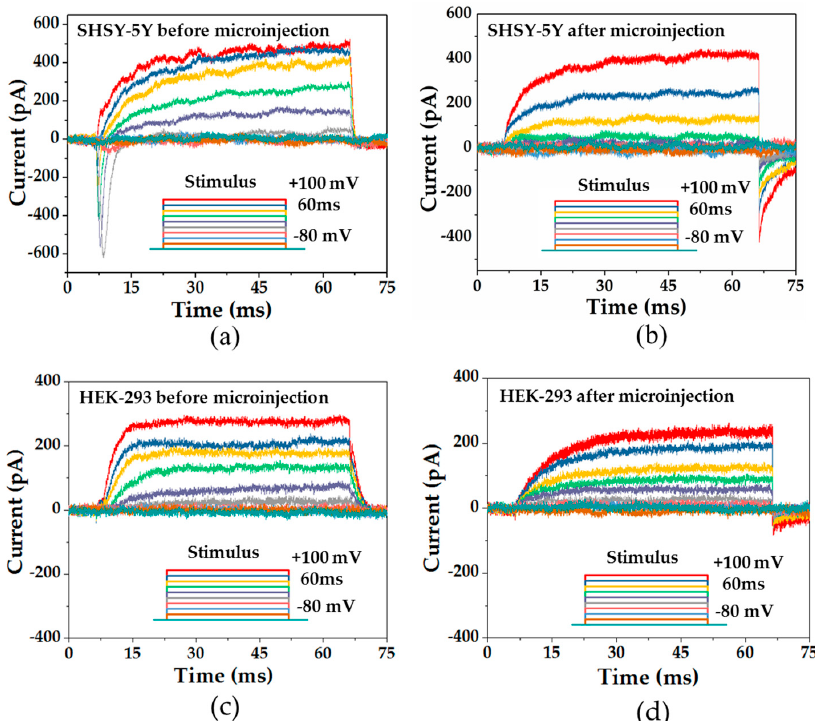
Figure 7. The current traces of ion channels and the voltage stimulus of a SHSY-5Y cell: ( a ) before the microinjection and ( b ) after the microinjection. The current traces of ion channels and the voltage stimulus of a HEK-293 cell: ( c ) before the microinjection and ( d ) after the microinjection.